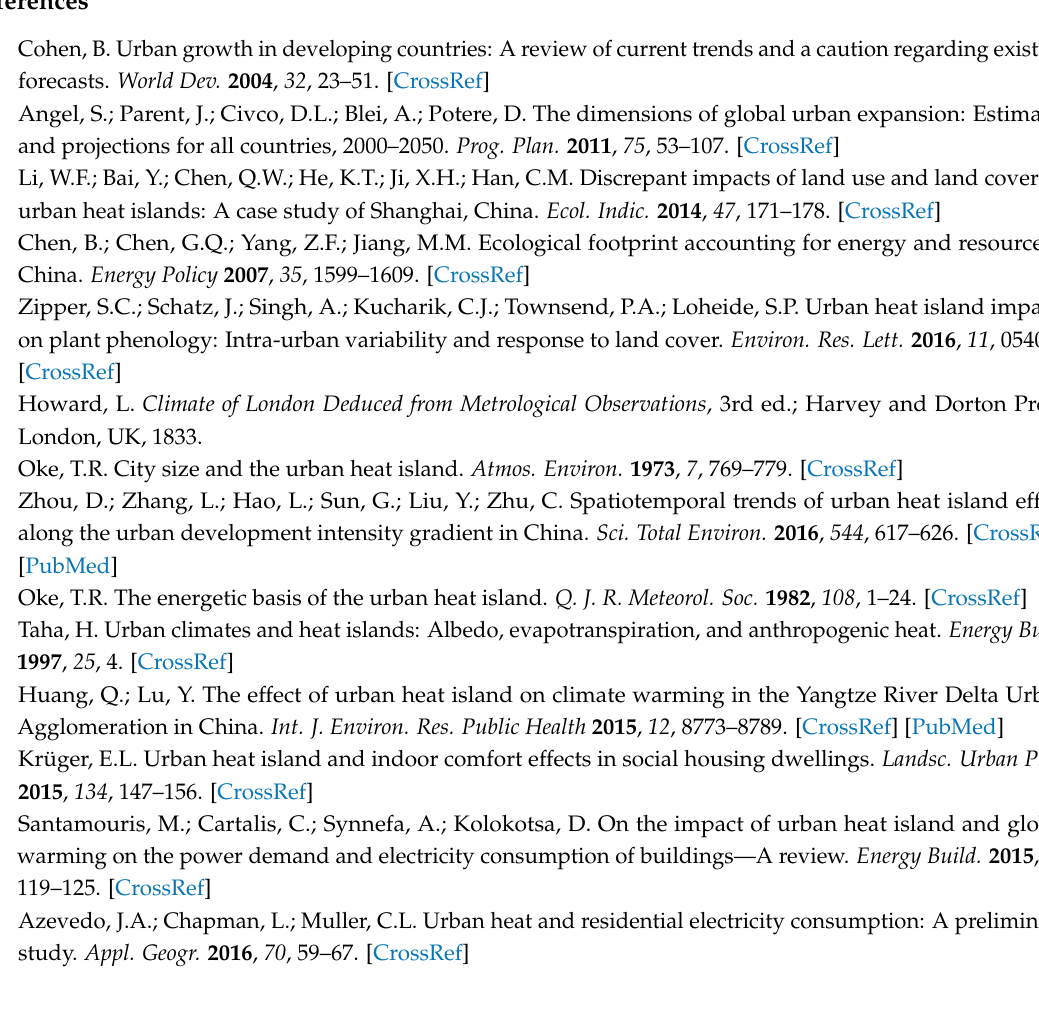
Table S1: The constants for LST retrieval with different types of thermal infrared data, Table S2: The time series of the area percentage of the six land use/cover (%), Table S3: The importance value of tree species in the 34 sample plots of the UGSs (%), Figure S1: Fluctuations in the monthly (a) and yearly (b) mean air temperature from 1990 to 2015, where the mean value was calculated using data obtained from Yan’an city weather stations, Figure S2: The 20-min variations in the land surface heat island intensity during July 2015 under sunny weather at 34 open impervious surface sites located close to various green spaces in the core urban area of Yan’an City. The mean (blue line) and standard deviation (gray line) for each 20 min period are also